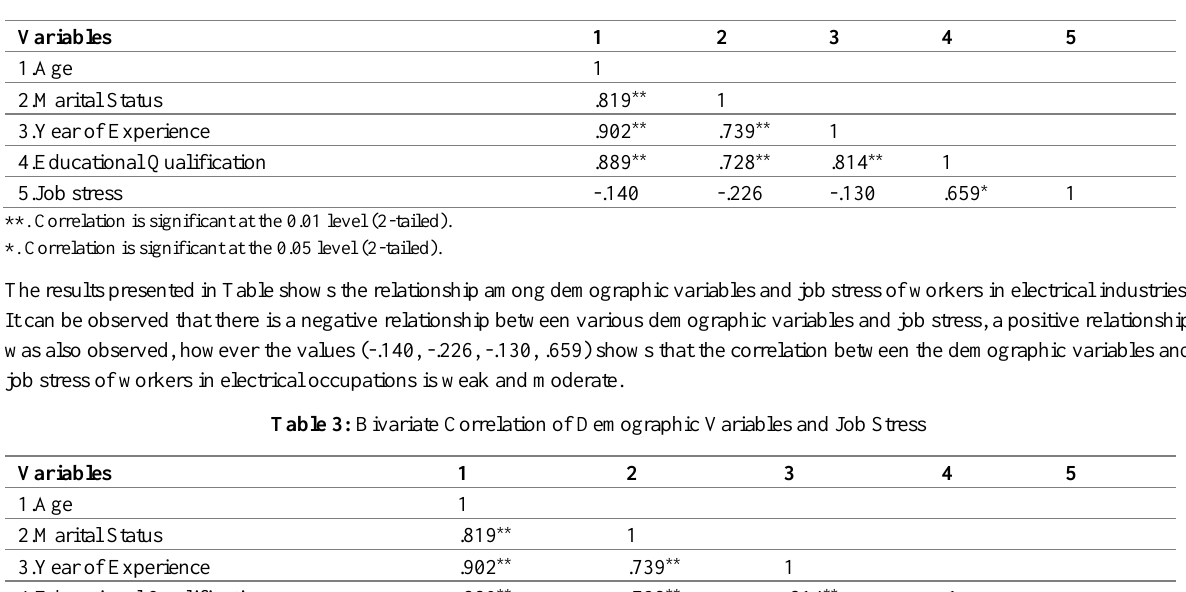
Table 2: Bivariate Correlation of Demographic Variables and Job Stress